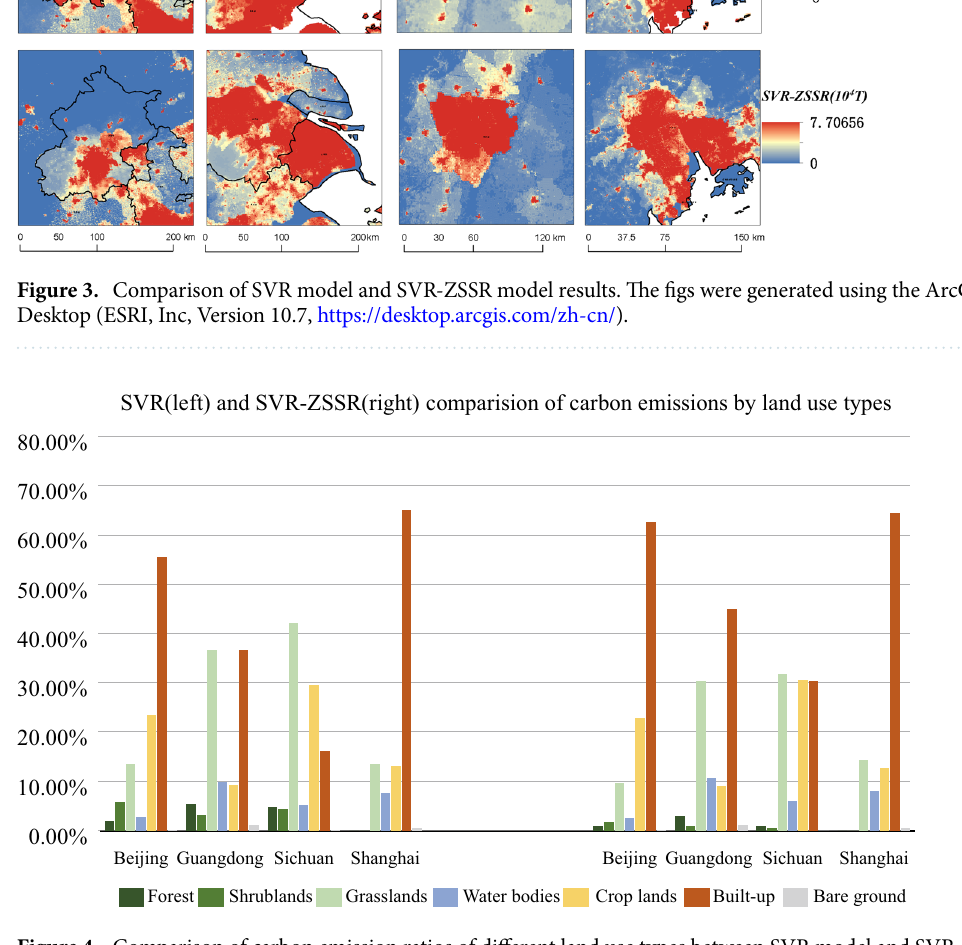
Figure 4. Comparison of carbon emission ratios of different land use types between SVR model and SVR-ZSSR